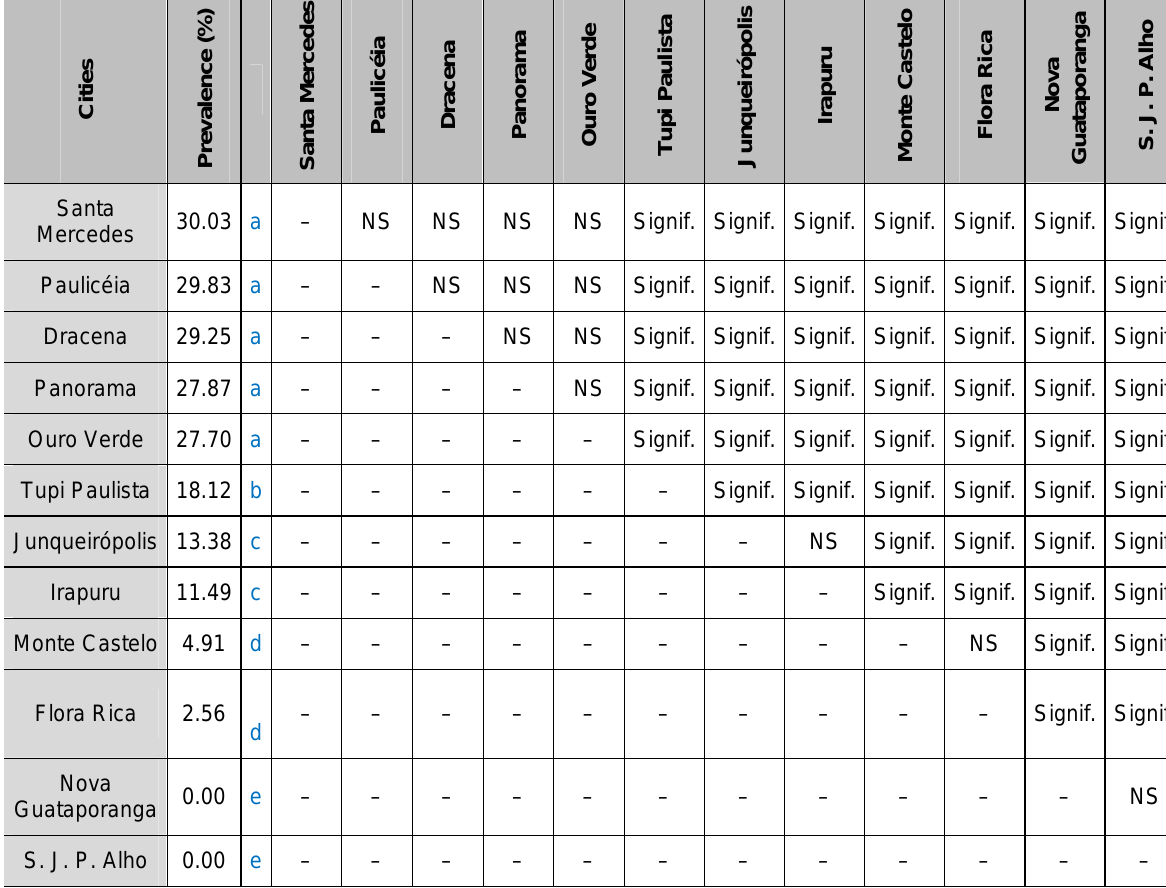
NS: results were not significant (p > 0.05); Signif.: results were significant (p < 0.05); a, b,